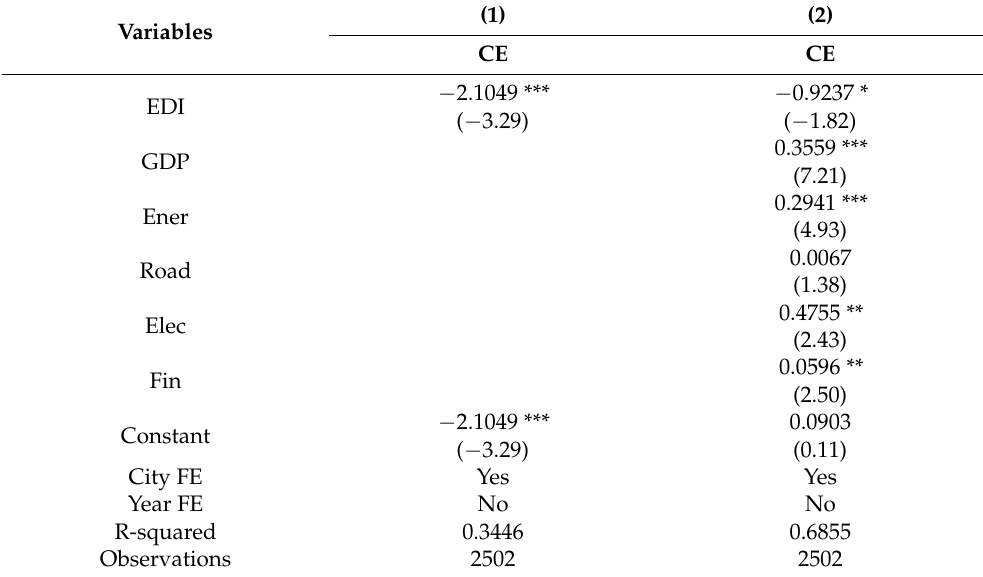
Table 3. Benchmark regression